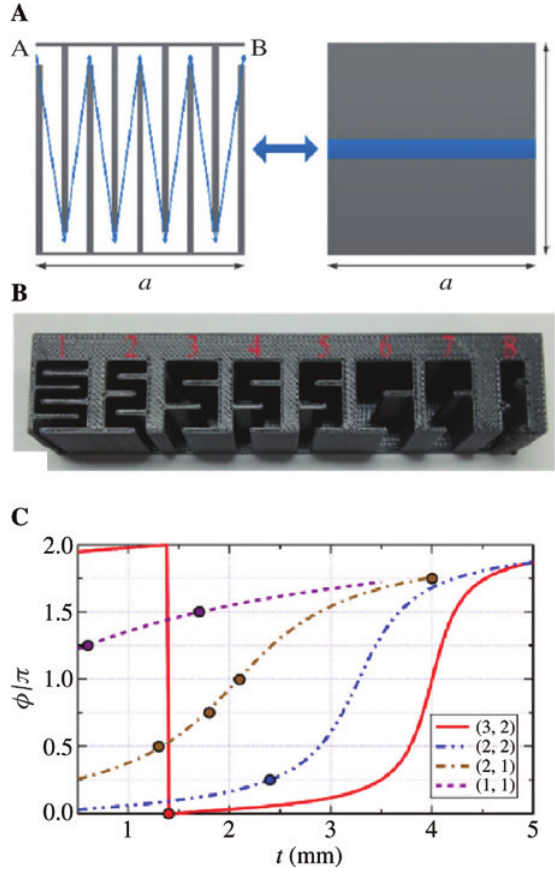
Figure 1: Reflective acoustic metasurface by coiling up space. (A) Schematic of space-coiling metamaterial units (left part) for mimicking a homogeneous effective medium with high refractive index. (B) Experimental sample of reflective-type acoustic metasurface (photo). (C) Simulated phase shift of metasurface units with different structural parameters (reprinted from Ref.